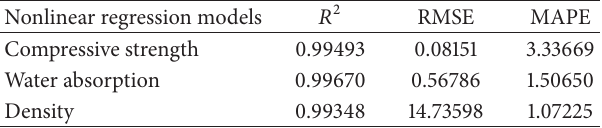
Table 6: Statistical performance of proposed regression